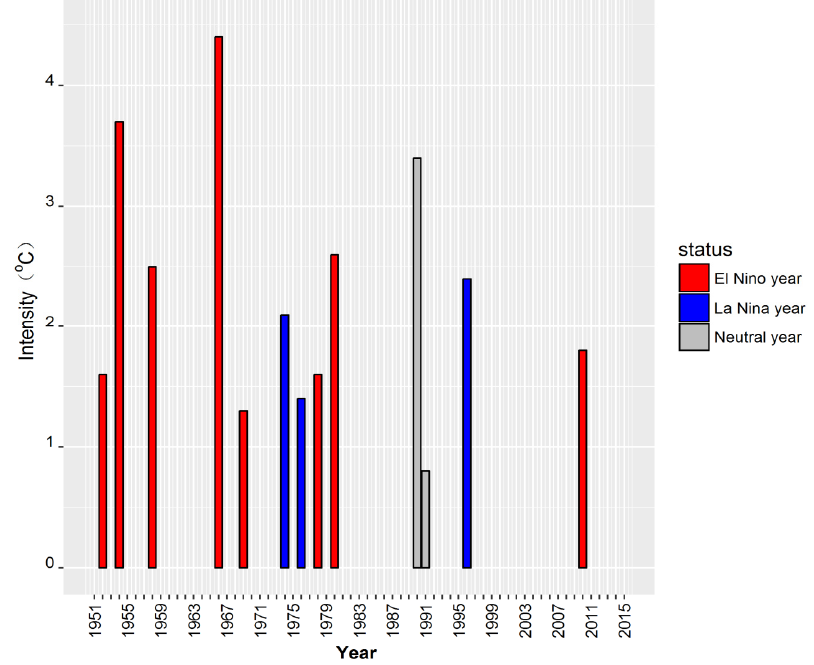
Figure 7. The intensity of cold spells in Guangzhou during 1951–2015. Annual intensity indicates the minimum value of daily minimum temperature during all cold spells in the year. The color of each bar shows the occurrence of El Niño years, La Niña years or Neutral years.